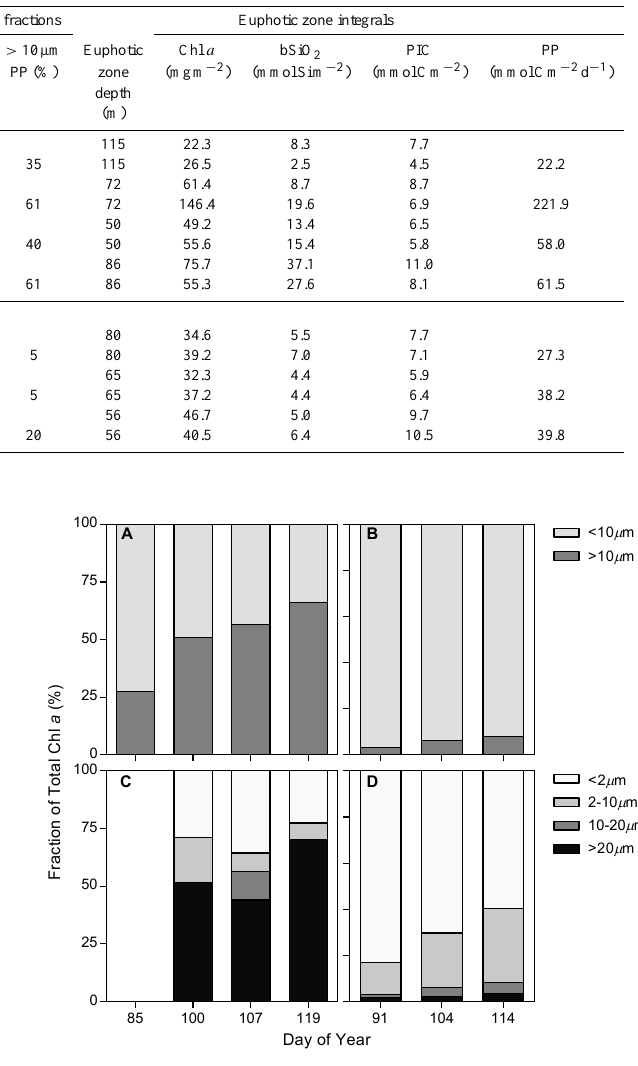
Figure 5. Size-fractionated Chl a for (a, c) the Iceland Basin, and (b, d) the Norwegian Basin. Plots (a) and (b) show the < 10 and > 10µm fractions, (c) and (d) show the < 2, 2–10, 10–20 and > 20µm